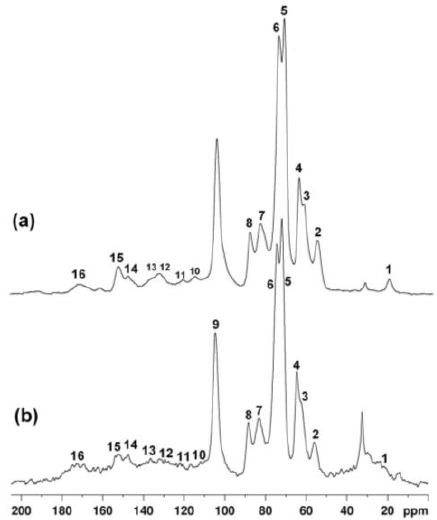
Figure 7. 13 C-CPMAS NMR spectra of a modern seasoned hardwood ( a ), and a fragment of wood sampled from the icon ( b